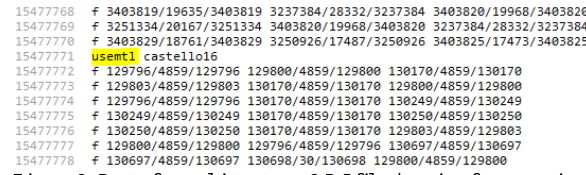
Figure 2: Part of a multi-textures OBJ file showing faces sections using usemtl directive